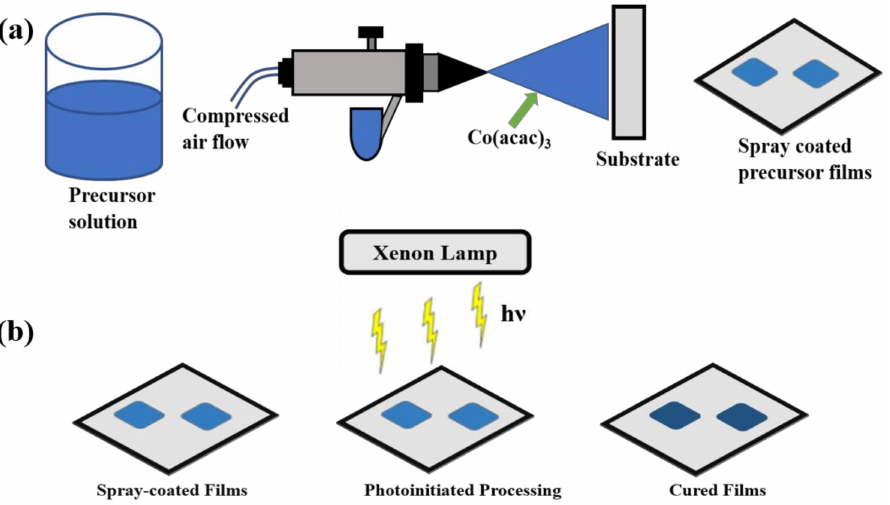
Figure 1. Schematic diagram of thin film ( a ) spray-coating technique and ( b ) curing using photoiniti- ated processing